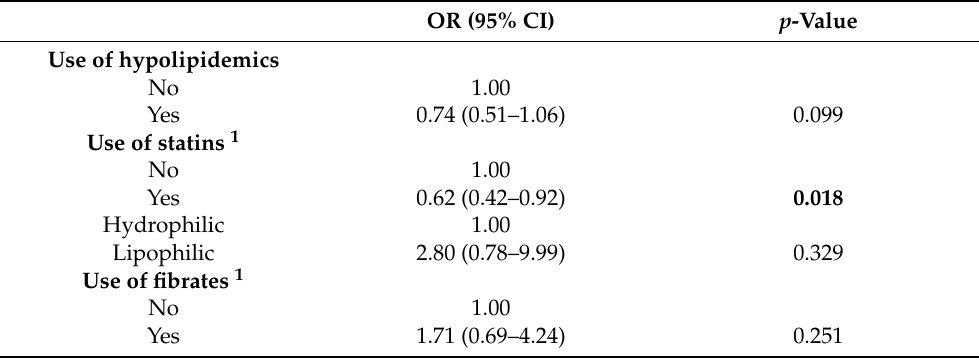
Table 4. Odds ratios for the occurrence of second primary malignancies derived from the multivariate logistic regression models.